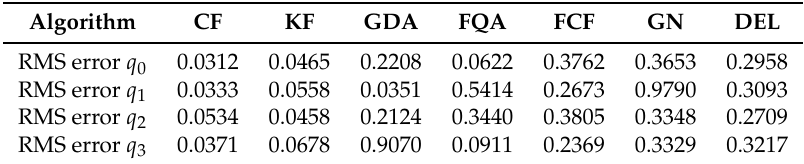
Figure 7. Measured and estimated quaternion (left) and error (right) of random movement. ( a ) Comparison among quaternions estimated by CF, KF, GDA, FQA algorithms and reference quaternions obtained from Hall sensor. ( b ) Comparison among quaternions estimated by FCF, GN, DEL algorithms and reference quaternions obtained from Hall sensor. Table 1. RMS errors of dynamic movement.